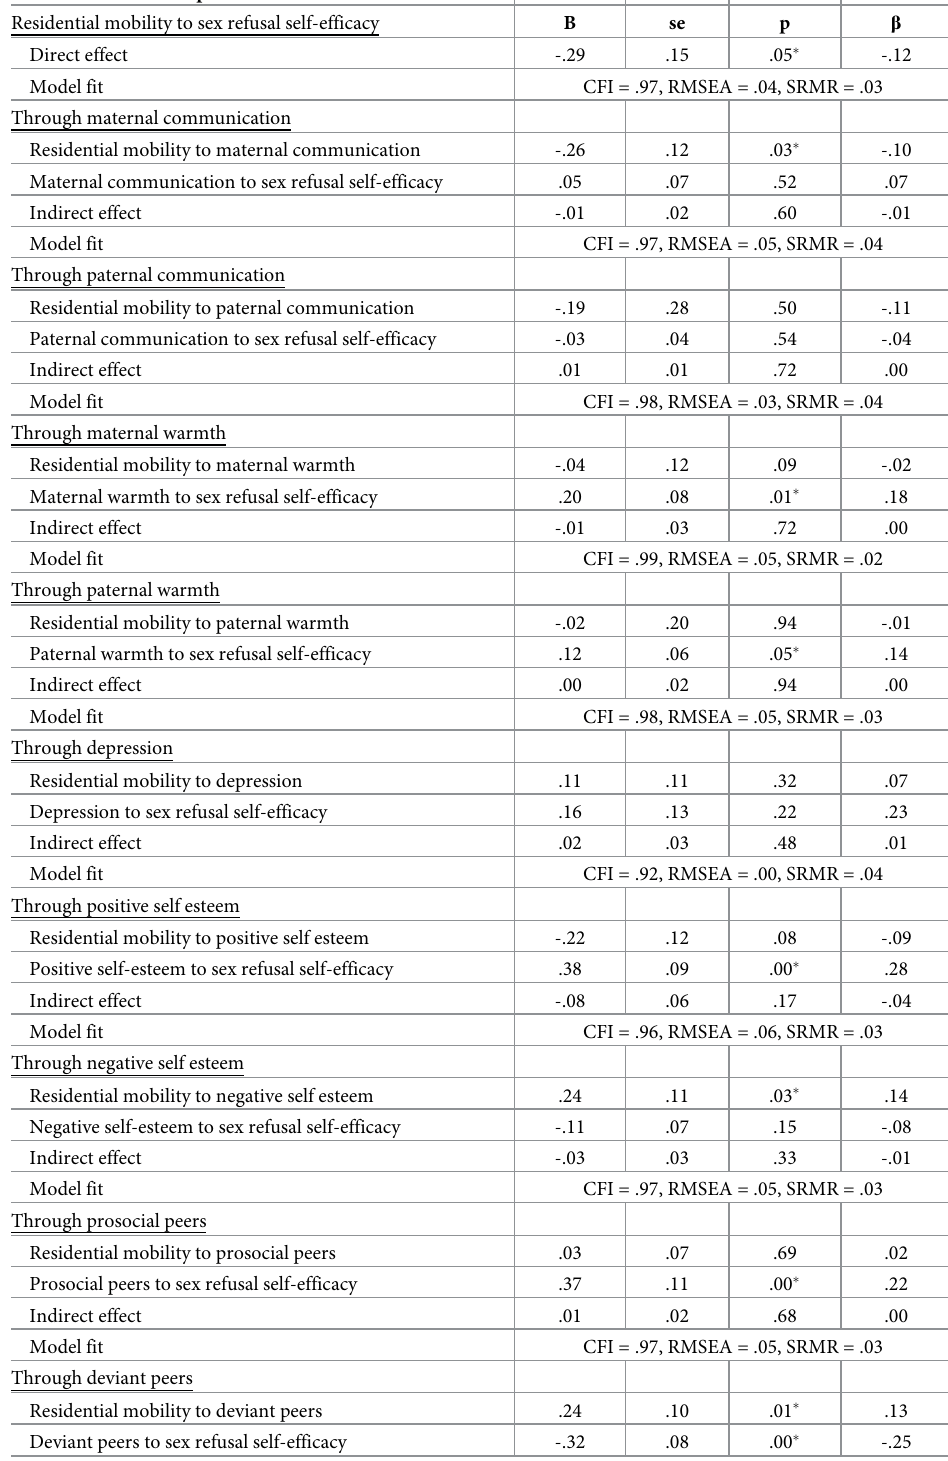
Table 3. Coefficients for structural equation mediational models of the direct and indirect relationships between residential mobility and sex refusal self-efficacy. Structural